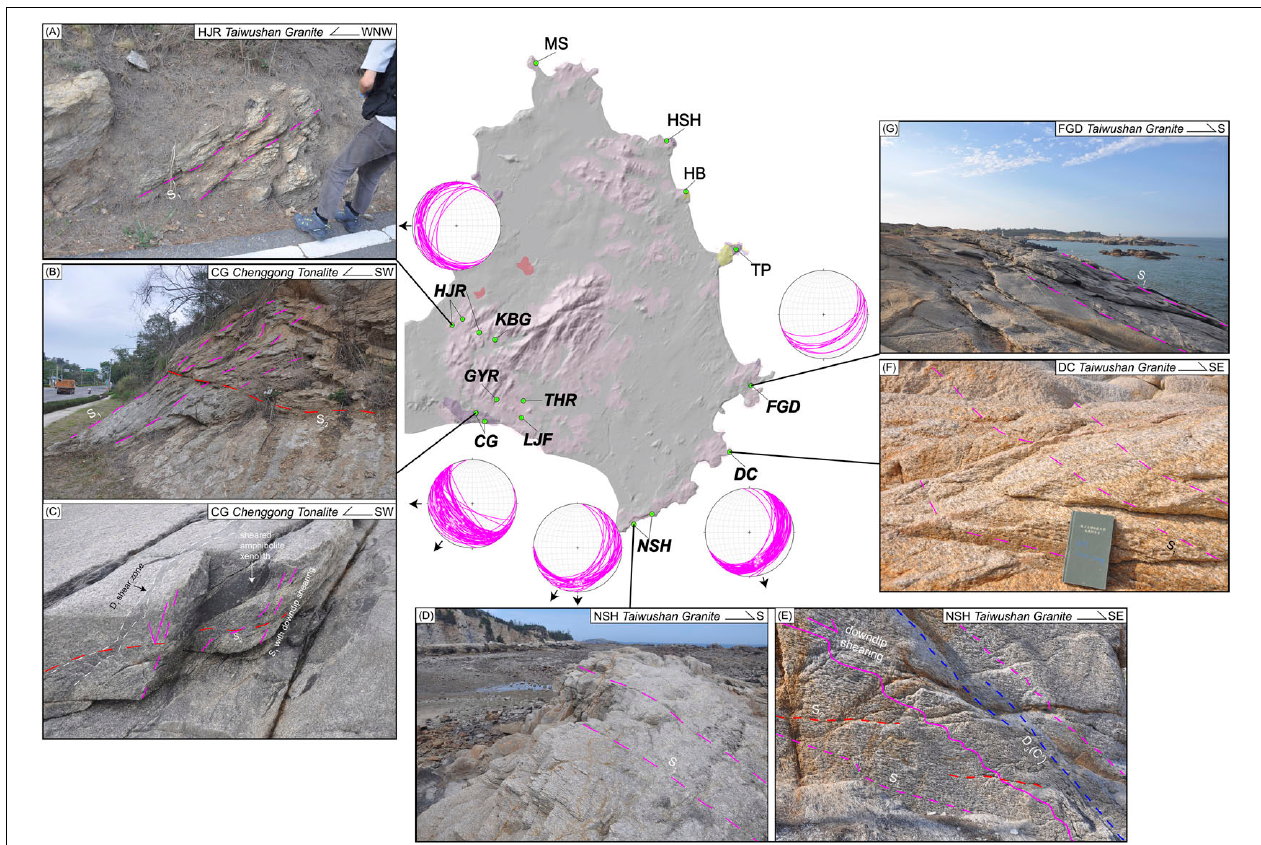
FIGURE 5 | Topographic map overlaid by the geological map showing outcrop photos with measured S 1 gneissic foliation and mineral lineation plotted with equal area southern hemisphere stereonet projection to demonstrate D 1 gneiss dome. The bold italic words indicate the sample locations with S 1 fabrics preserved. (A) The N-S striking and shallowly W-dipping gneissic foliation with poorly to none mineral lineation developed at HJR. (B,C) The NW-SE striking, shallowly to moderately SW-dipping gneissic foliation (S 1 ) with well-developed W and SW plunging lineation at CG. The S 1 fabric is deformed into a wavy form due to the subhorizontal S 2 foliation. The sheared amphibolite xenolith indicates the down-dip shearing along the S 1 foliation. (D,E) The NE-SW striking, shallowly to moderately SE-dipping gneissic foliation (S 1 ) with well-developed SW and S plunging lineation at NSH. The kinking of S 1 foliation is owing to the weak development of the subhorizontal S 2 foliation, both of which are crosscutted by D 3 shear zone (C’ fabric). (F) The NE-SW striking, moderately SE-dipping gneissic foliation (S 1 ) with well-developed SSE plunging lineation at DC. (G) The ENE-WSW striking, moderately SE-dipping gneissic foliation (S 1 ) with none lineation developed at